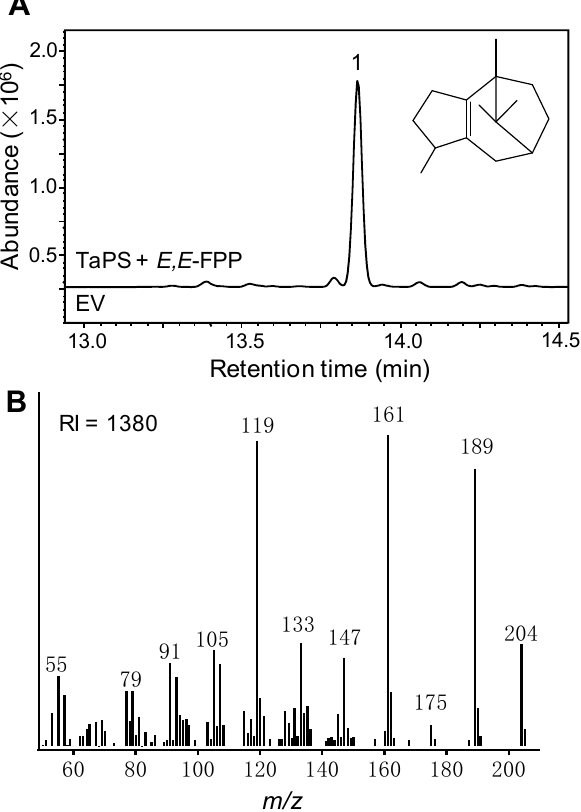
Figure 1. Wheat β -patchoulene synthase (TaPS) catalyzed β -patchoulene formation. ( A ) Gas chromatography-mass spectrometry (GC-MS) chromatogram of extract from the culture co-overexpressing TaPS and farnesyl diphosphate (FPP) synthase in E. coli . The empty vector (EV) control was also shown. The product β -patchoulene was labeled as peak 1 and the chemical structure was shown as well. ( B ) Mass spectrum of peak 1. The calculated retention index (RI) was shown.